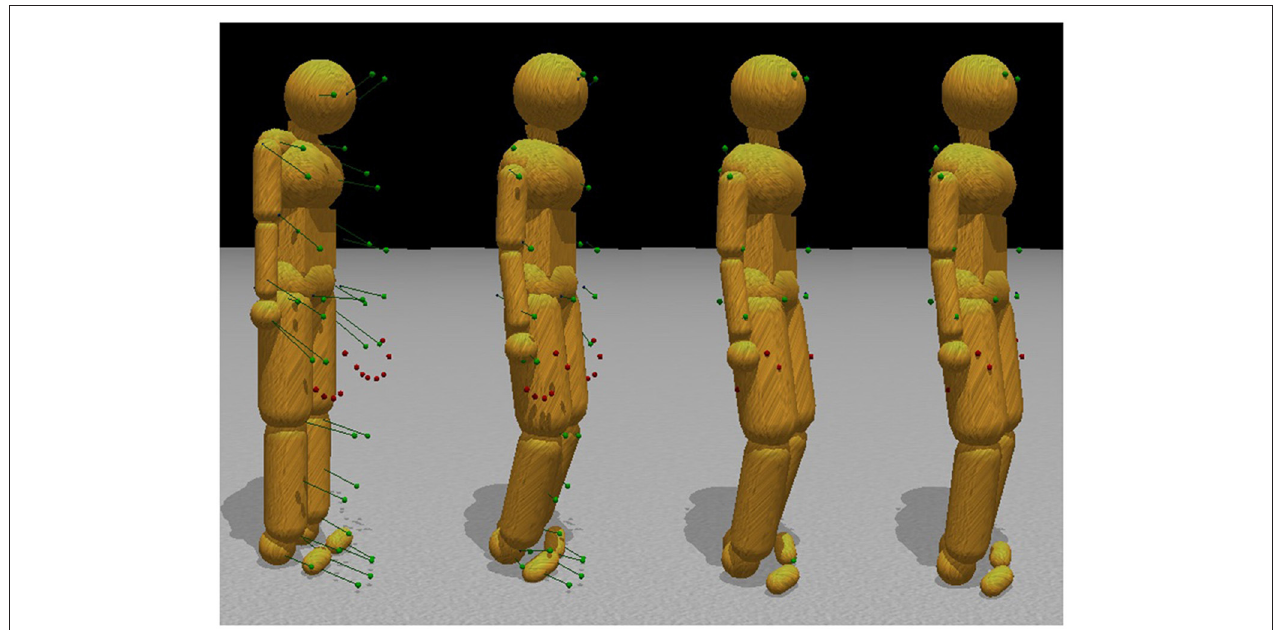
FIGURE 3 | Pose fitting. Initially, the motion capture data points are in a very different configuration than the initial stance of the model. To find the appropriate correspondences, simulated markers attach to the humanoid model through ball-and-socket joints and pull the body parts into place, subject to model joint constraints. The left to right sequence in the figure shows the body targets being gradually reconciled with the external